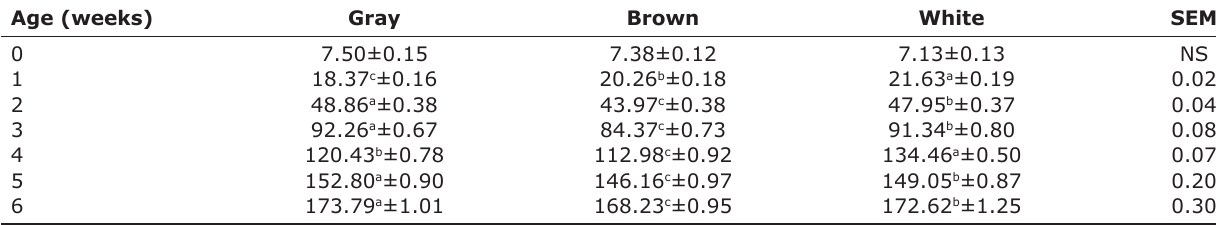
Table-1: Weekly body weight (g) of three varieties of Japanese quail. Age (weeks) Gray Brown